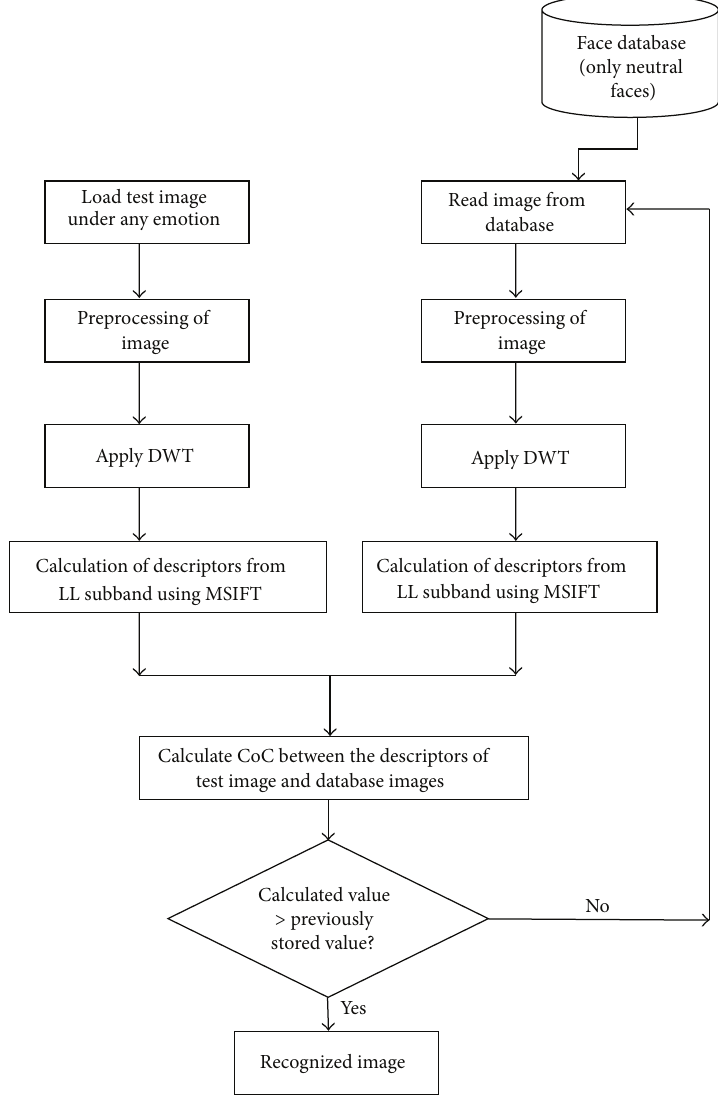
Figure 4: Proposed model of face recognition technique.